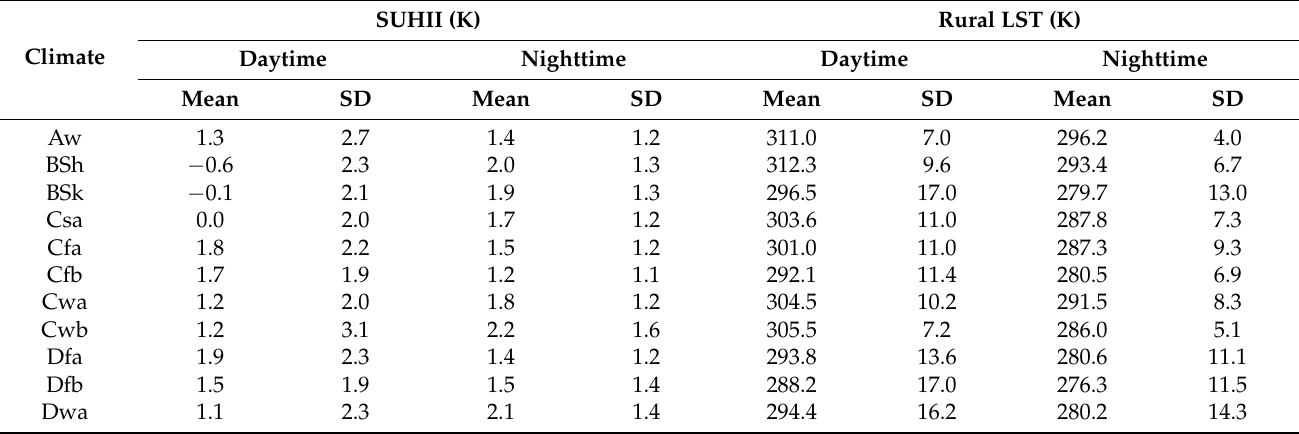
Table 3. The mean and the standard deviation (SD) of the 2000–2018 daily SUHII and rural LST shown in Figure